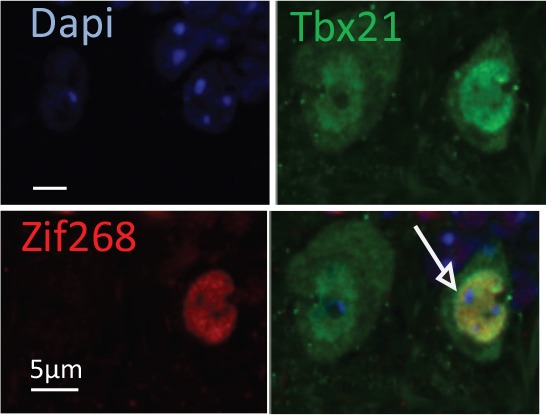
Example of Tbx21/Zif268-positive mitral cell.This image is representative of all cells counted.